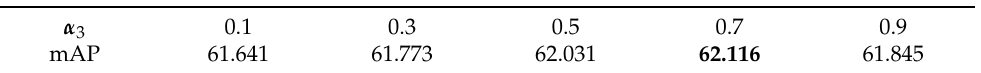
Table 3. Test results of different α 3 on the DOTA validation dataset ( λ has been fixed to 1.25, and α 2 has been fixed to